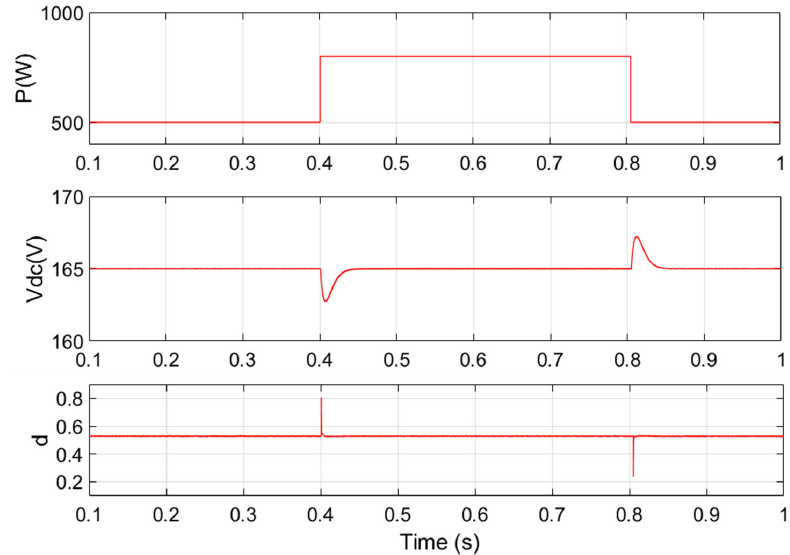
Figure 6. Simulation results with large CPL power variation.